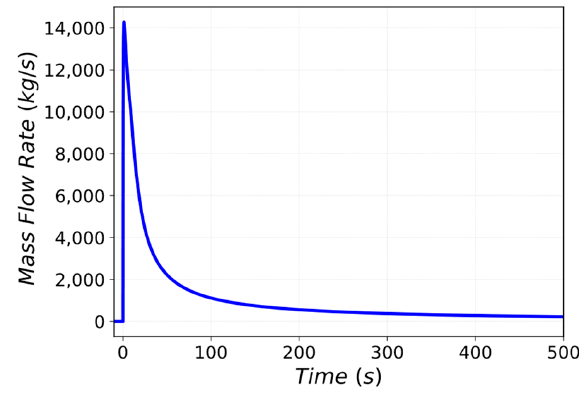
Figure 8. Mass flow rate from ring HX cold leg.